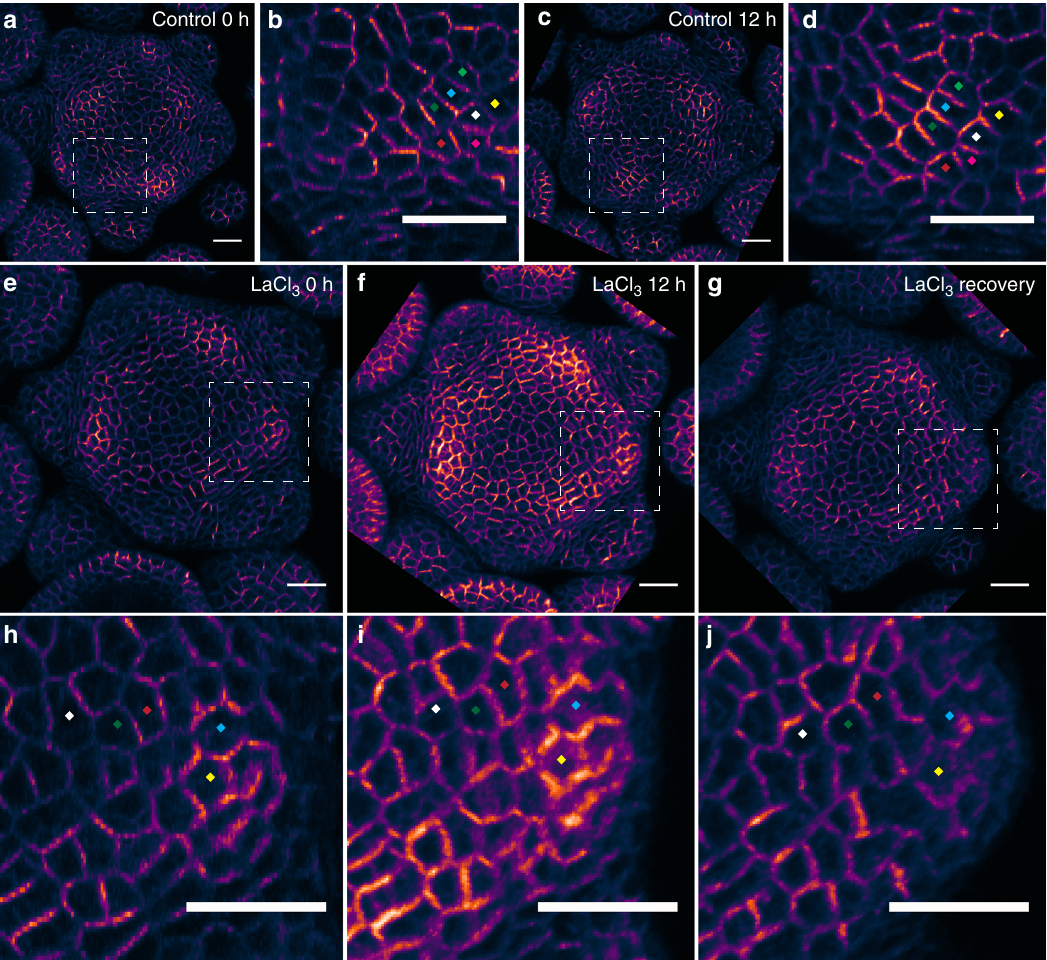
Fig. 1 PIN1 dynamic polarization pattern during 12 h growth after 5 mM LaCl 3 treatment. a , c PIN1-GFP signal indicates a new primordium forming after 12 h (dashed square). b , d Enlargement of the square region in a , c . Colored dots indicate the cells that had PIN1-GFP polarity changed over 12 h of growth. e – g PIN1-GFP dynamic polarization pattern freezes after repeated application of 5 mM LaCl 3 for 2 min in every hour for 12 h without sample rinse ( f ), but primordia resume growth and PIN1-GFP signal relocalizes in the dashed square region after 12 h of recovery following water rinse ( g ). h – j Enlargement of the square region in e – g . The cells that are labeled by colored dots show that PIN1-GFP does not repolarizes during LaCl 3 treatment but resumes a dynamic pattern after a 12 h recovery. a – j scale bar: 20 µ m. LUT is gem in Fiji-ImageJ